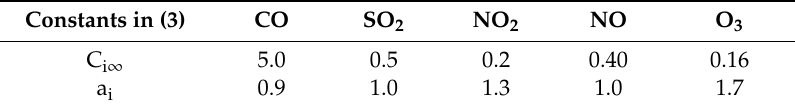
Table 5. The constants for calculating the Air Pollution Index